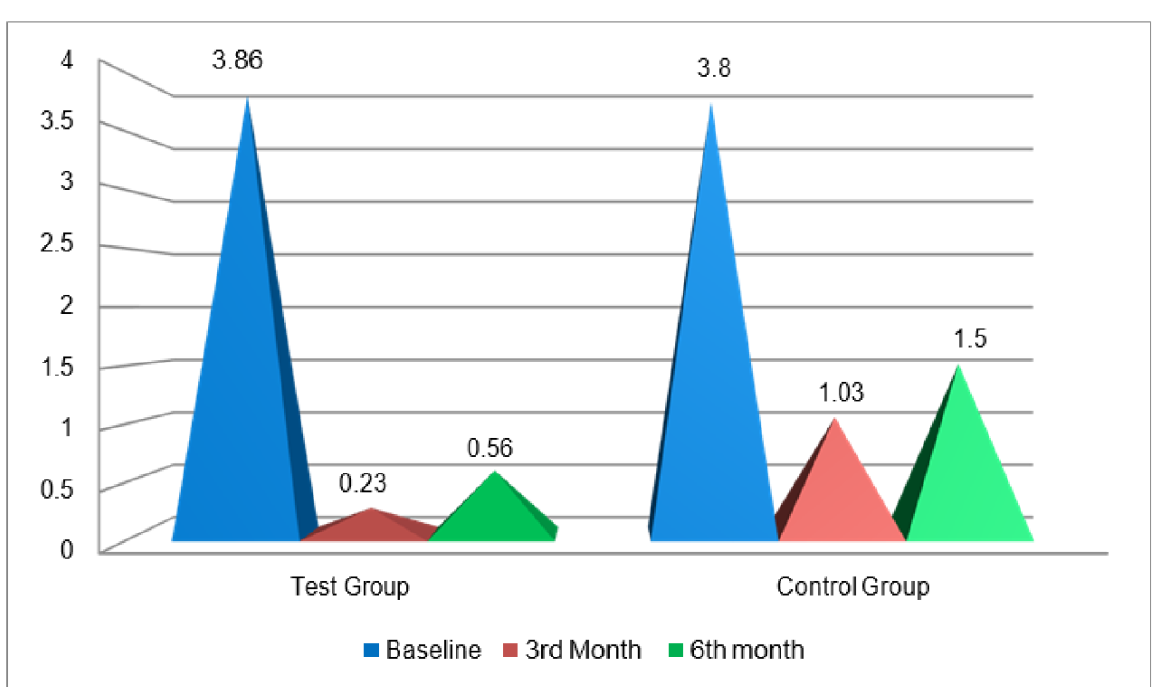
Figure 4. Intra-group comparison of gingival recession width. Table 3. Inter-group comparison of gingival recession width.